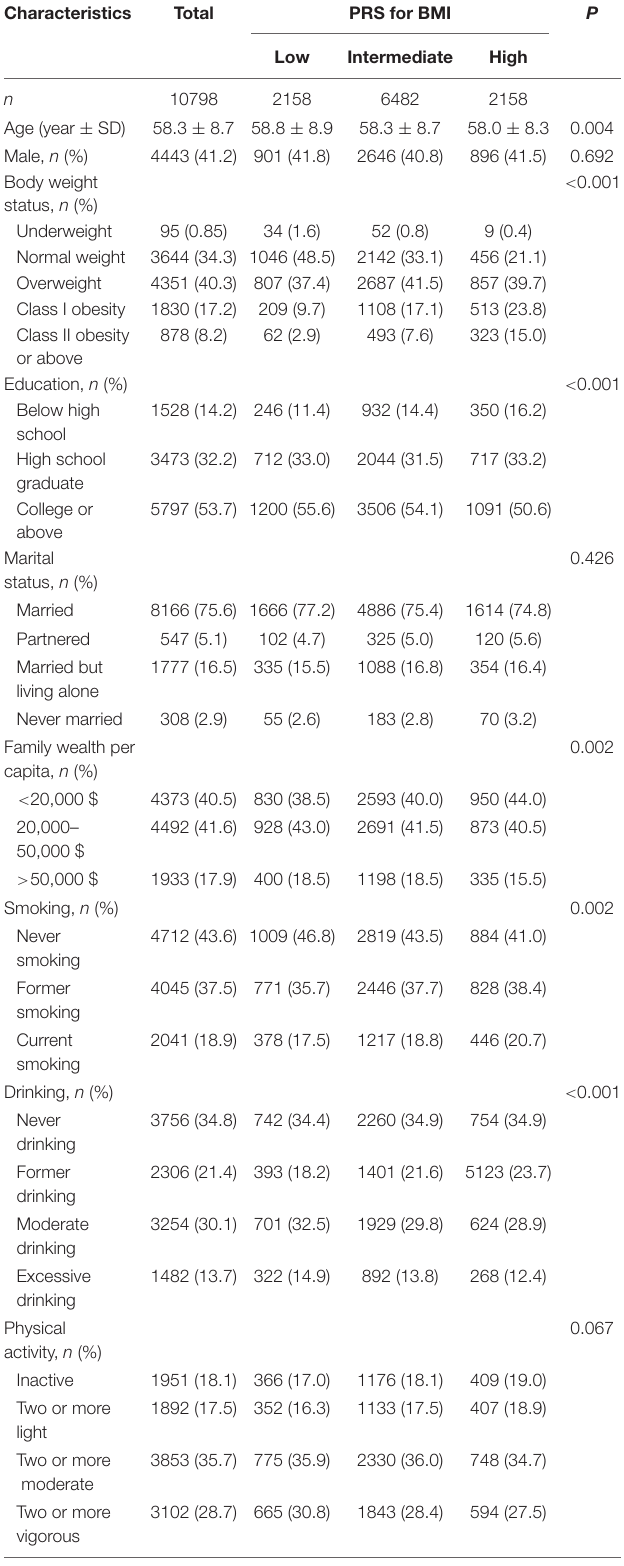
TABLE 1 | Characteristics of the participants stratified by PRS for